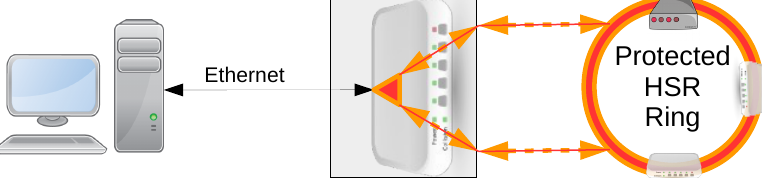
Figure 13. MACsec into protected HSR maintains HSR compatibility in the ring. Short dashed lines indicate standard HSR traffic. Black lines indicate standard Ethernet. MACsec and HSR tags are included at the same point so that MACsec can secure HSR, and the outermost layer is HSR so the traffic in the ring is HSR compliant. Legacy equipment (top switch/DAN) can communicate using non secure channels with any other equipment in the